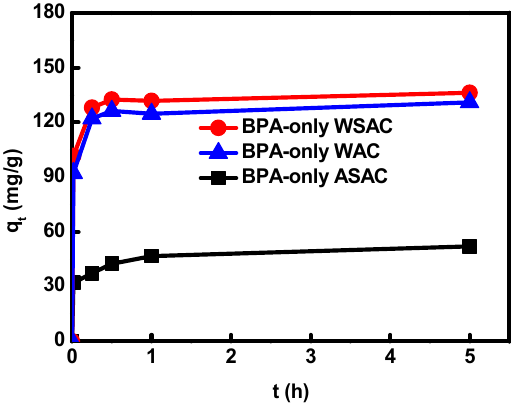
Figure 1. The adsorption kinetic curves of BPA onto ACs in single solution. Table 4. Adsorption kinetic parameters of BPA onto ACs in single solution.